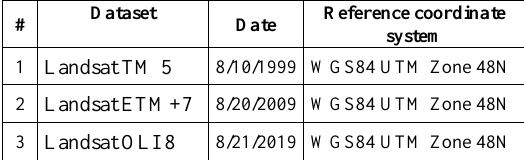
Table 1. List of satellite data